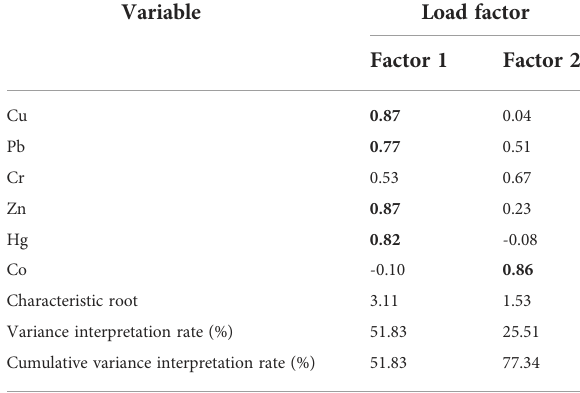
The bold numbers represent higher factor